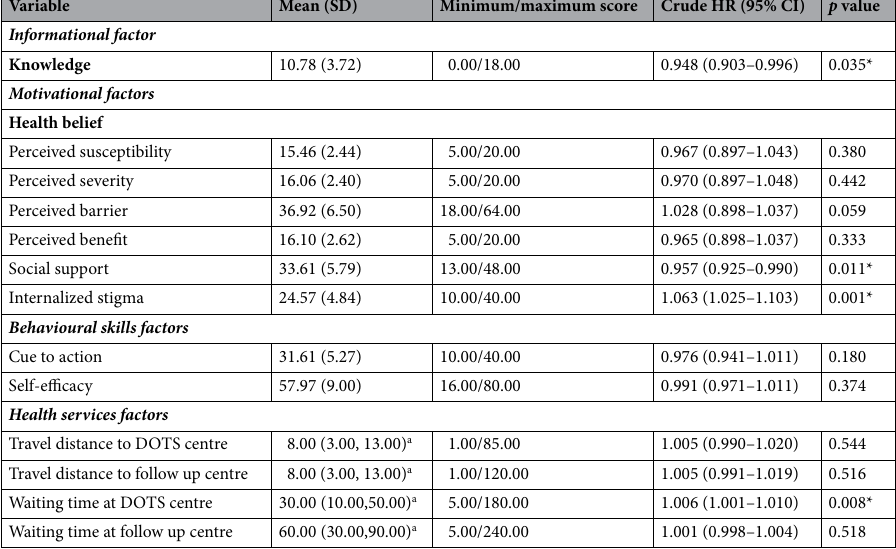
Table 4. Risk of early treatment interruption by information, motivation, behavioural skills and health service factors (n = 439). HR Hazard Ratio, CI Confidence Interval, SD Standard deviation. *p < 0.05. a median (IQR).